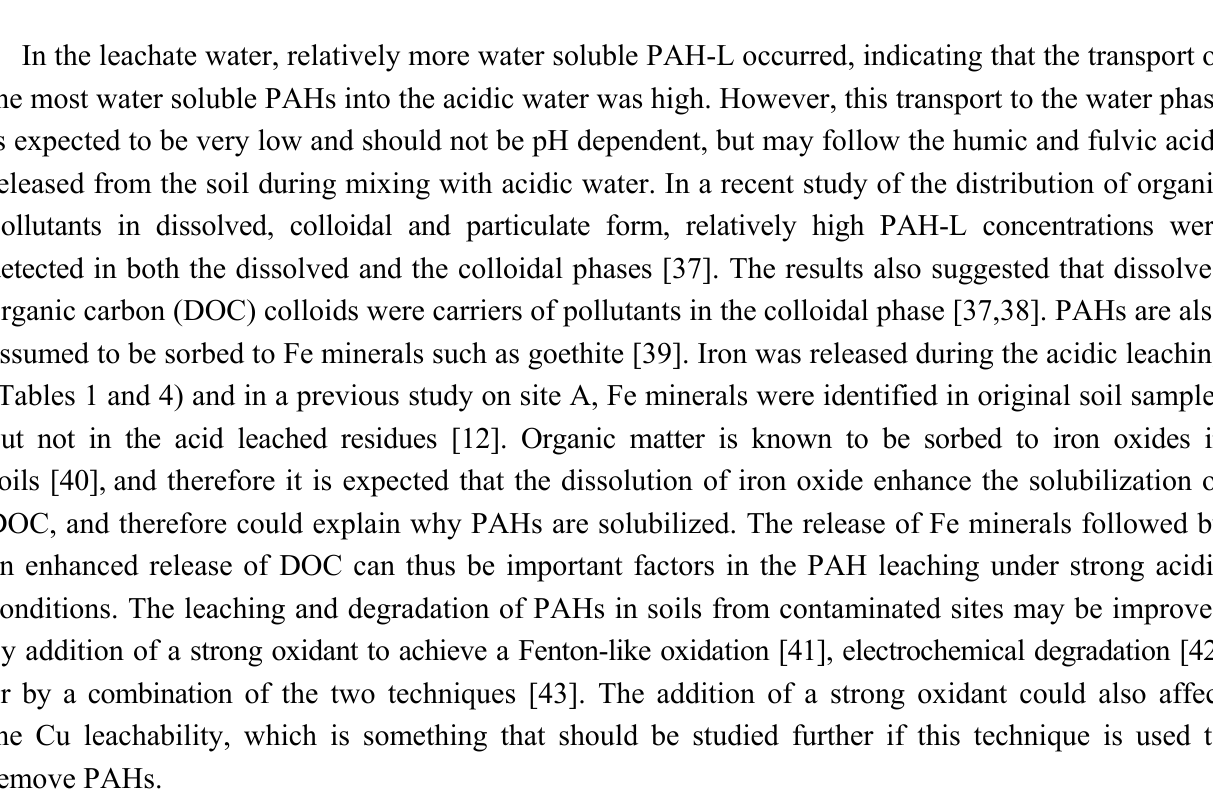
Figure 7. Concentrations of PAHs and oxy-PAHs analyzed in the A1 spiked soil sample before and after acidic washing (mg/kg), and the concentrations in the corresponding acidic leachate ( μ